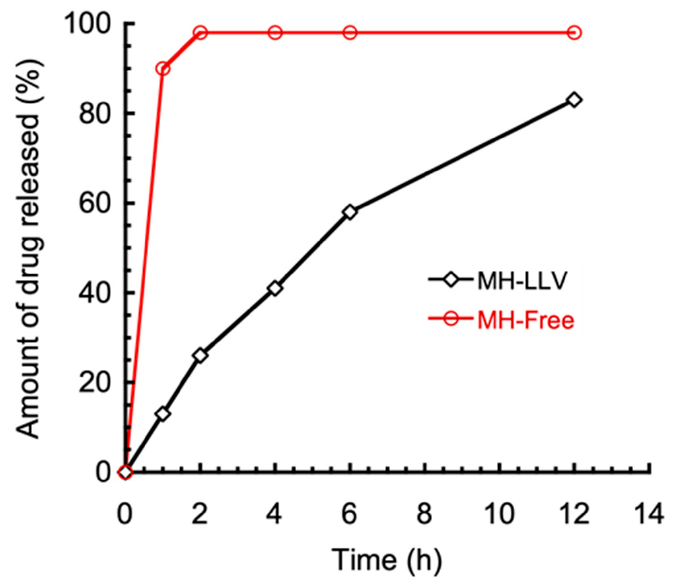
Figure 3. The in vitro drug release study of metformin hydrochloride-loaded lipid vesicles (MH- LLVs).